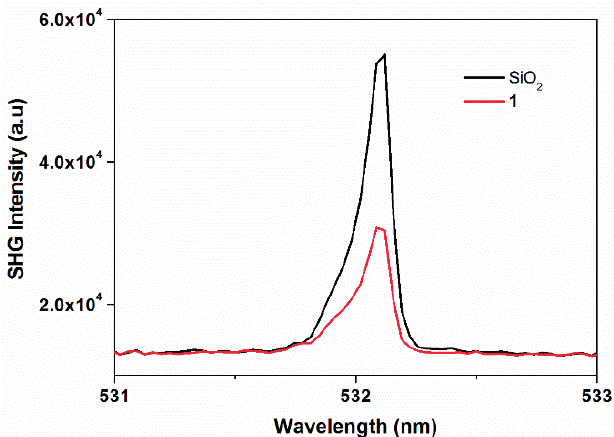
Figure 5. SHG plot of compound 1